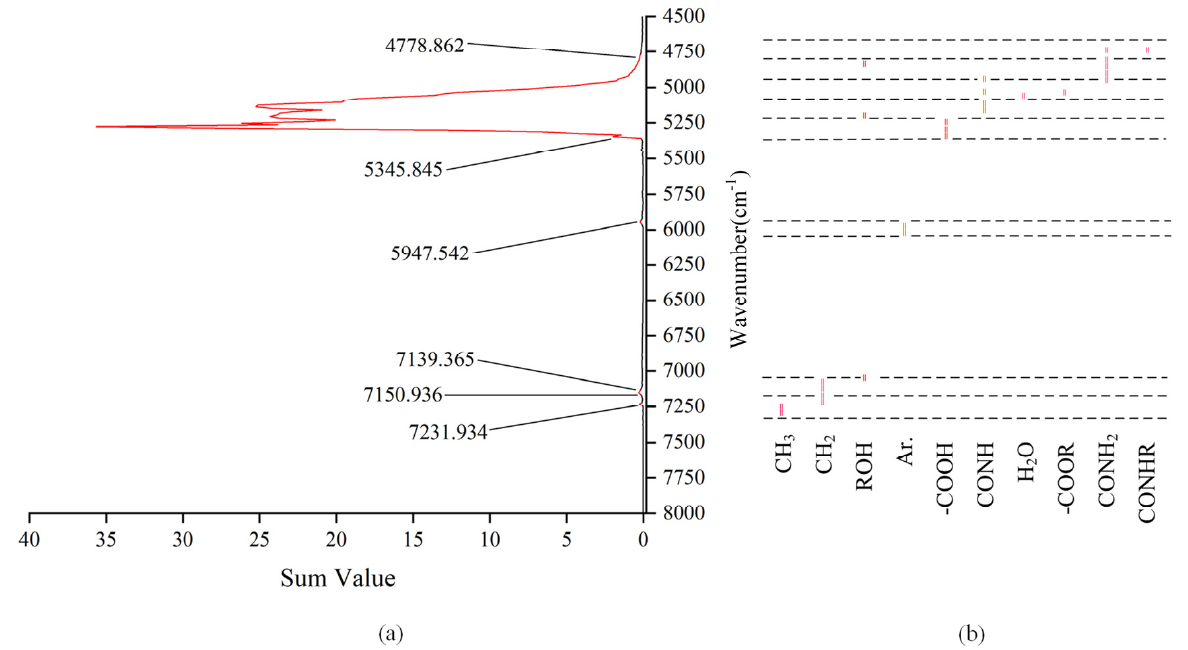
Figure 10. ( a ) Processing result of the sparse tensor of five classes of liquor; ( b ) main groups of the absorption band at the characteristic wavenumbers (“=”: the absorption position of the group).